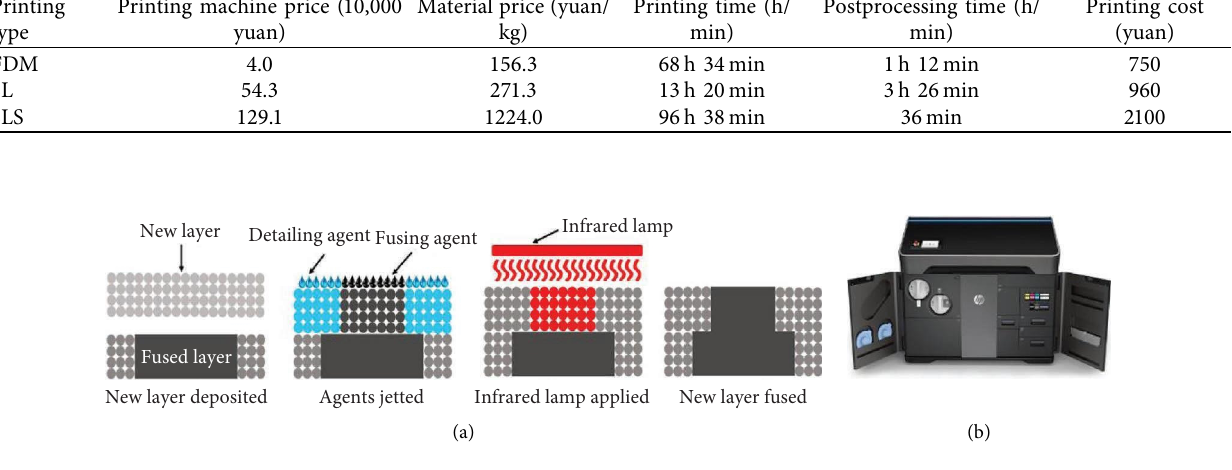
Figure 10: MJF printing principle (a) and equipment (b).